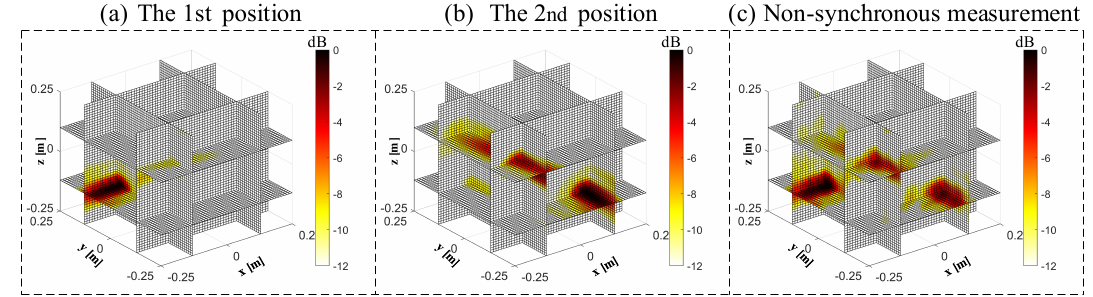
Figure 18. Comparison of the 3D beamforming results between a single planar microphone array and the non-synchronous measurements. ( a ) The 1st position; ( b ) the 2nd position; ( c ) the non-synchronous measurements. Figure 19. With the single microphone array placed in the 1st position (i.e., parallel to the y-z plane), two sound sources can be located at the upper-left and lower-right quadrants at the x = − 0.13 m plane. At the y = − 0.13 m and z = − 0.13 m plane, beamforming maps are not used to determine the sources’ positions due to the larger extension of the lobes. With the single microphone array placed in the 2nd position (i.e., parallel to the x-z plane), the beamforming map at the y = − 0.13 m plane exhibits two major lobes that correspond to the positions of the two sound sources. At the x = − 0.13 m and z = − 0.13 m plane, the main lobes extend so badly that it is impossible to find the sound source positions exactly. When the non-synchronous measurements are adopted, the spatial resolution in both the x = − 0.13 m and y = − 0.13 m planes is improved relative to the single microphone array. For the z = − 0.13 m plane, the beamforming map is improved slightly with the non-synchronous measurements than with the single microphone array. Comparing the beamforming between the non-synchronous measurements and the single microphone array suggests that the non-synchronous measurements improve the spatial positioning resolution of the planar microphone array.